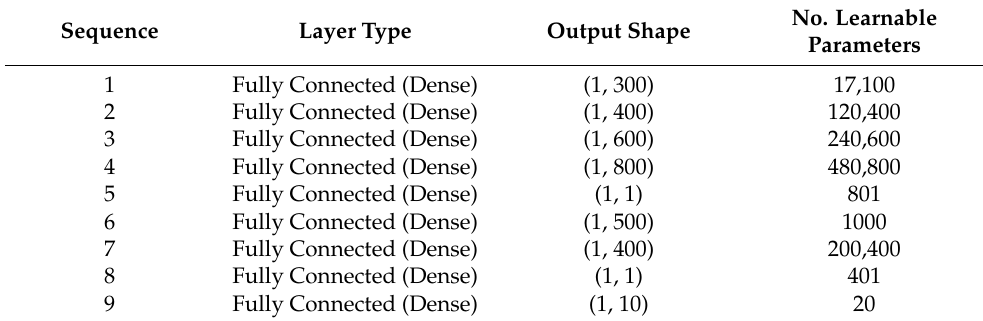
Table 2. ANN, second model, layers